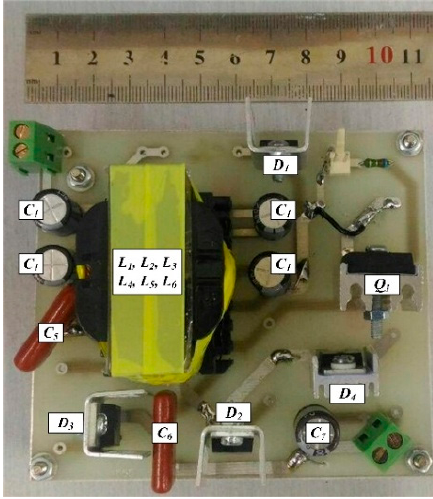
Figure 10. Implemented prototype of the proposed converter .